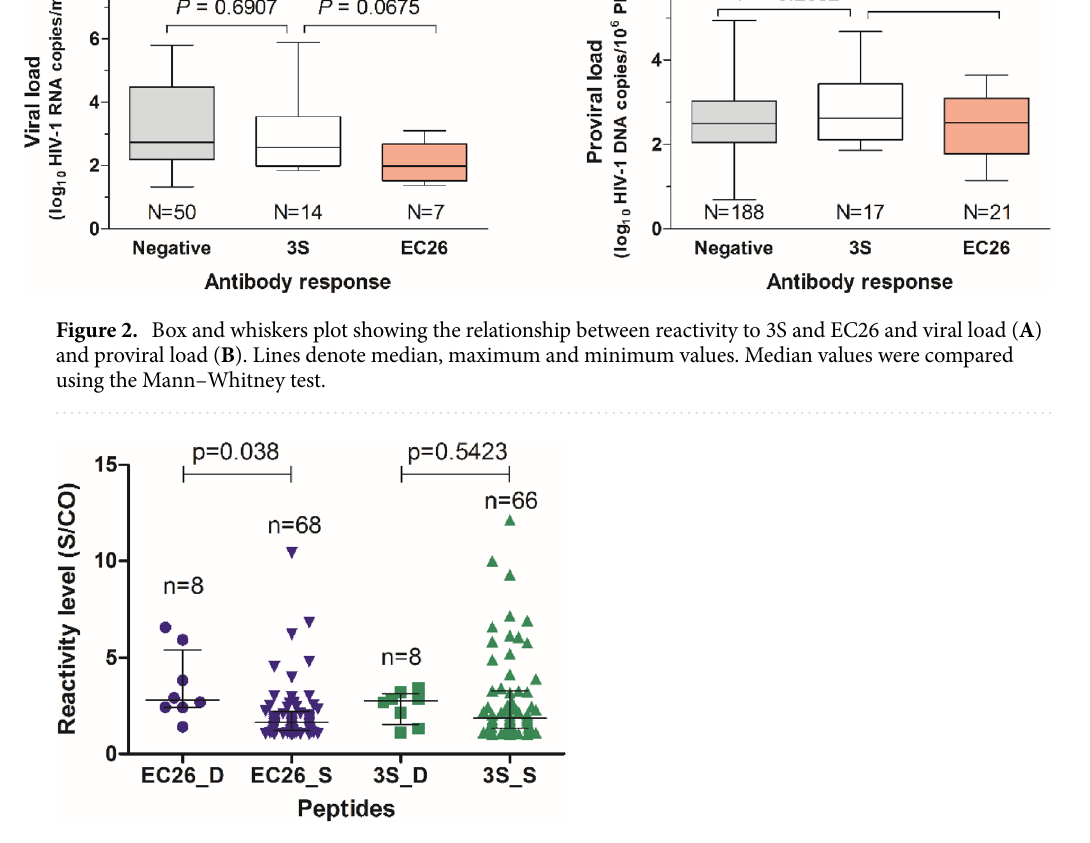
Figure 3. Level of reactivity against the 3S and EC26 peptides in plasma samples from patients showing single (S) or double (D) reactivity against 3S and EC26. Lines denote median and interquartile range. Statistical significance was determined using the Mann–Whitney